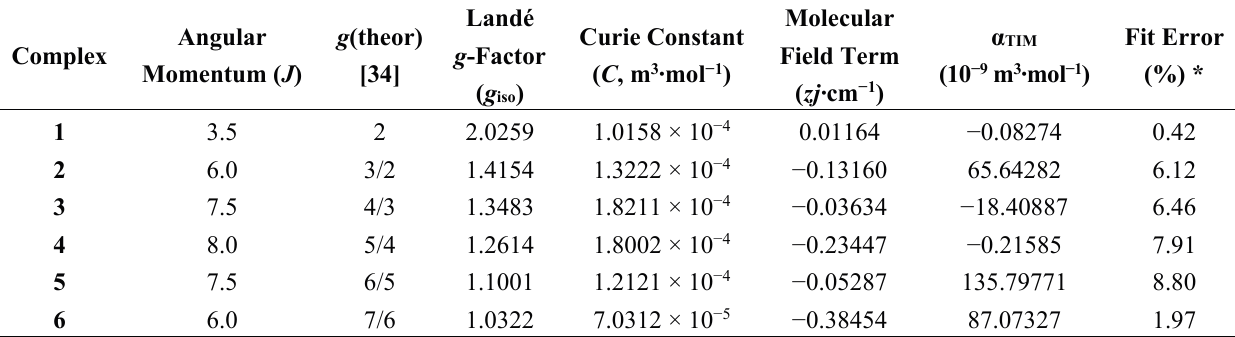
Table 4. Best fitting parameters of temperature dependence of magnetic susceptibility for complexes ( 1 – 6